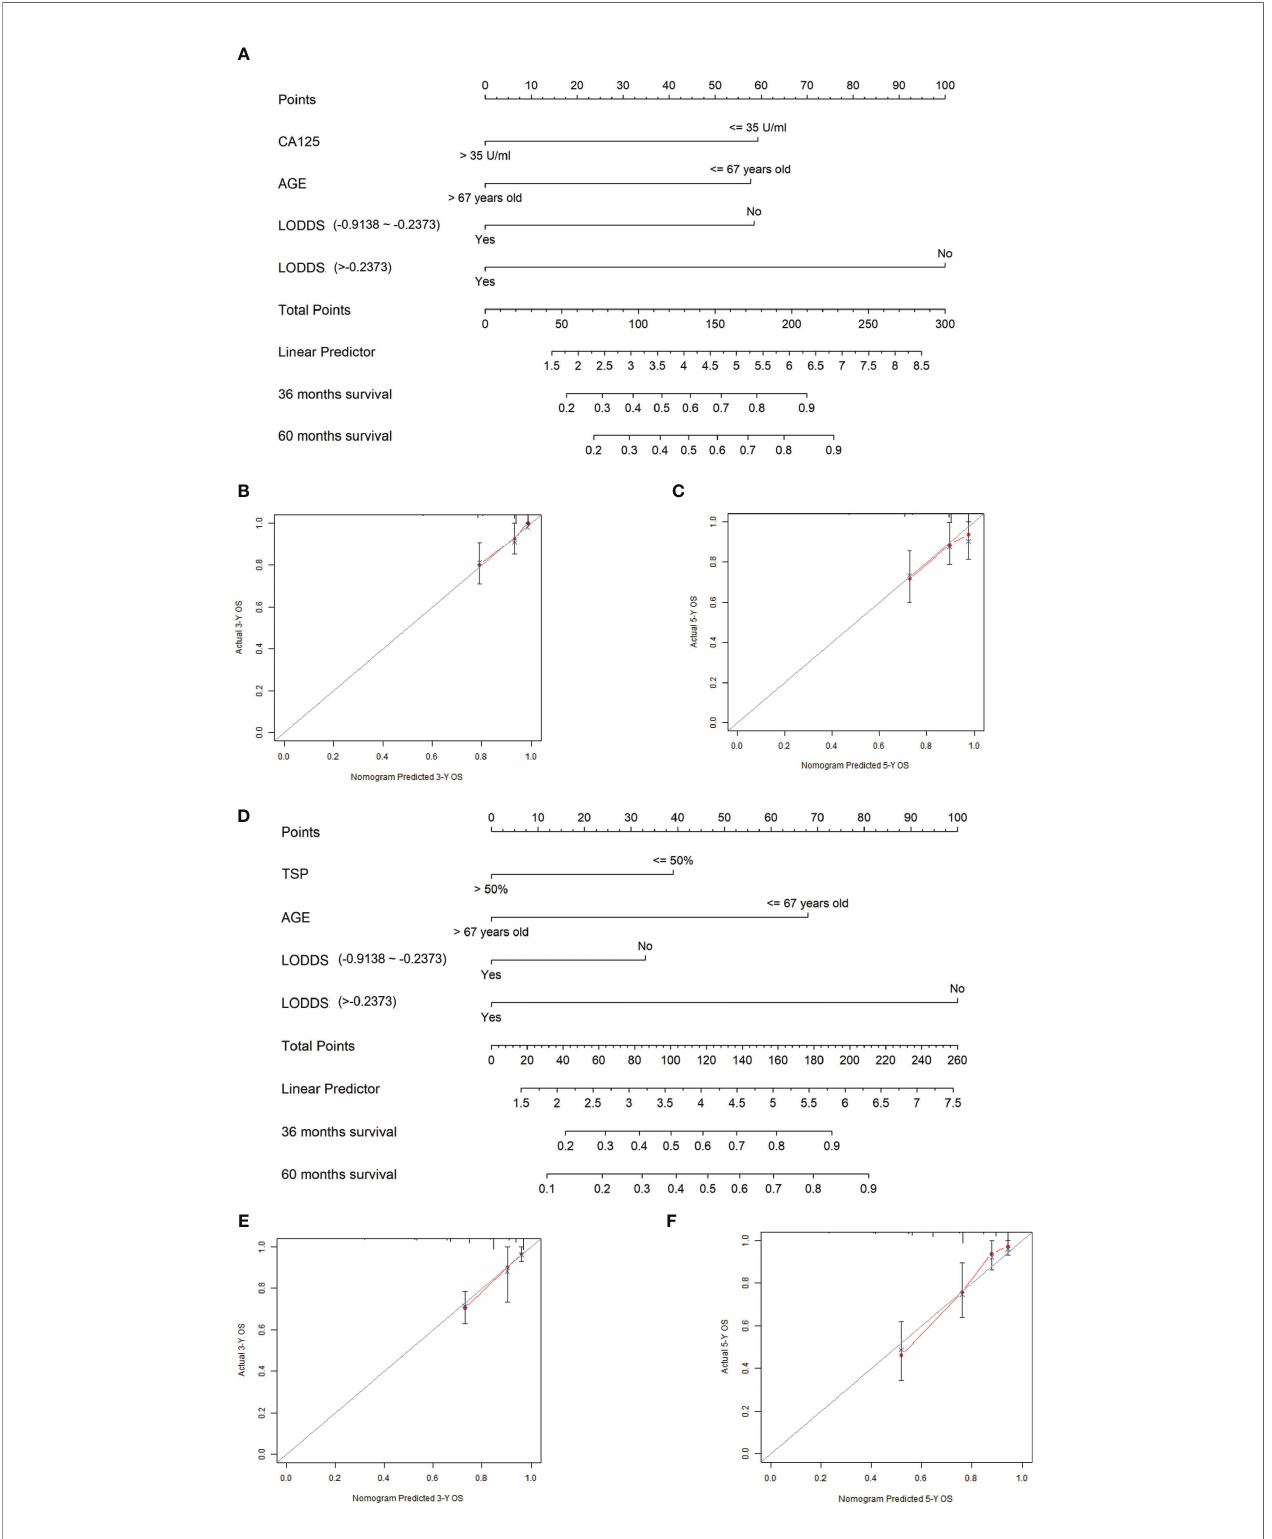
FIGURE 2 | Construction and validation of the nomogram. (A) The nomogram to predict 3-year and 5-year survival probability for patients with LSCC. (B, C) The calibration curves of 3- and 5-year survival probability in LSCC patients. (D) The nomogram to predict 3-year and 5-year survival probability for patients with RSCC. (E, F) The calibration curves of 3- and 5-year survival probability in RSCC